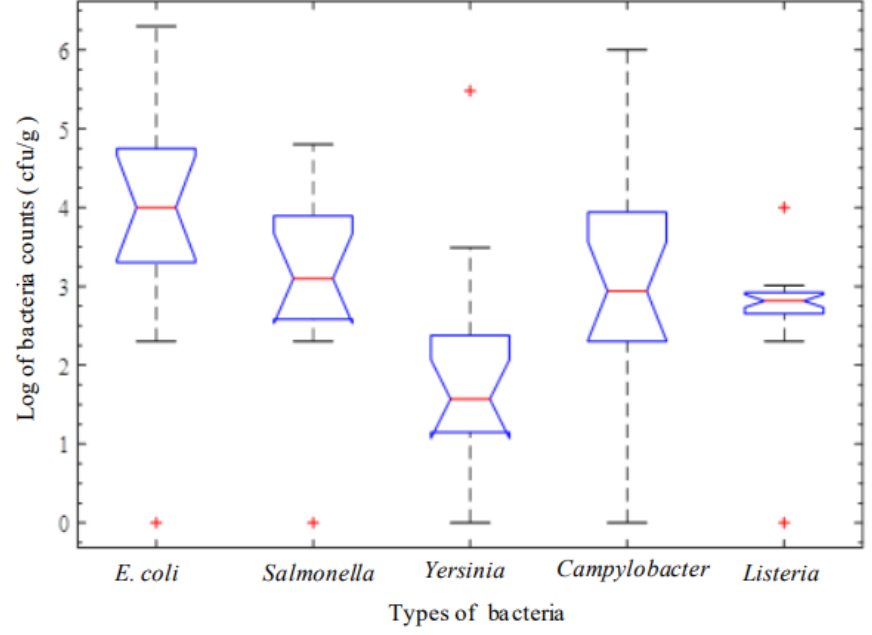
Figure 3. ANOVA plot of the group means of log bacterial counts of the different species. For each of the groups, the major blue plot represents the ANOVA plots for each bacterium, the horizontal red line in each ANOVA plot represents the median for the group, the lower and upper black horizontal lines in each group represent the lower and upper confidence level in the group, respectively, and the red cross marker(s) in each group represent the outliers.